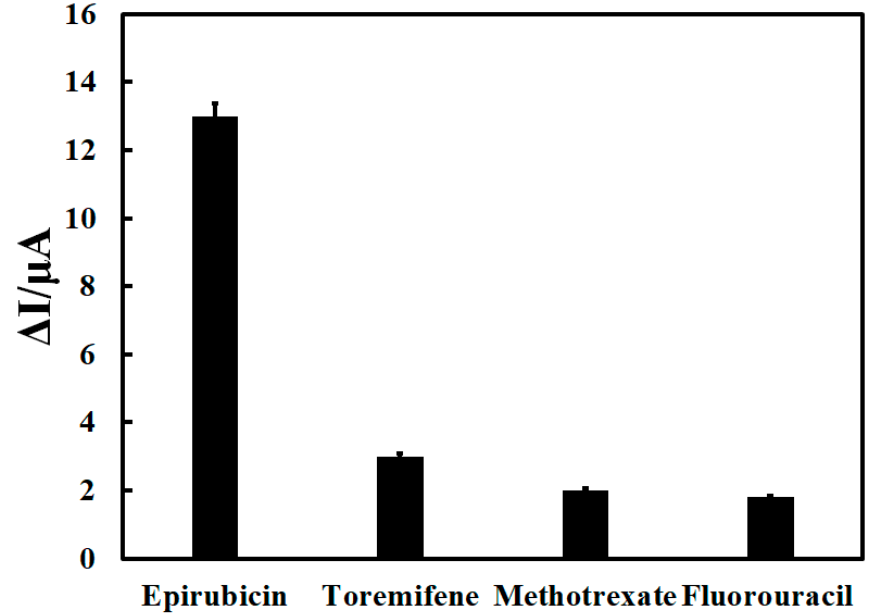
Figure 8. Investigating the selectivity of the prepared electrochemical aptasensor in 15 nM epirubicin measurement.